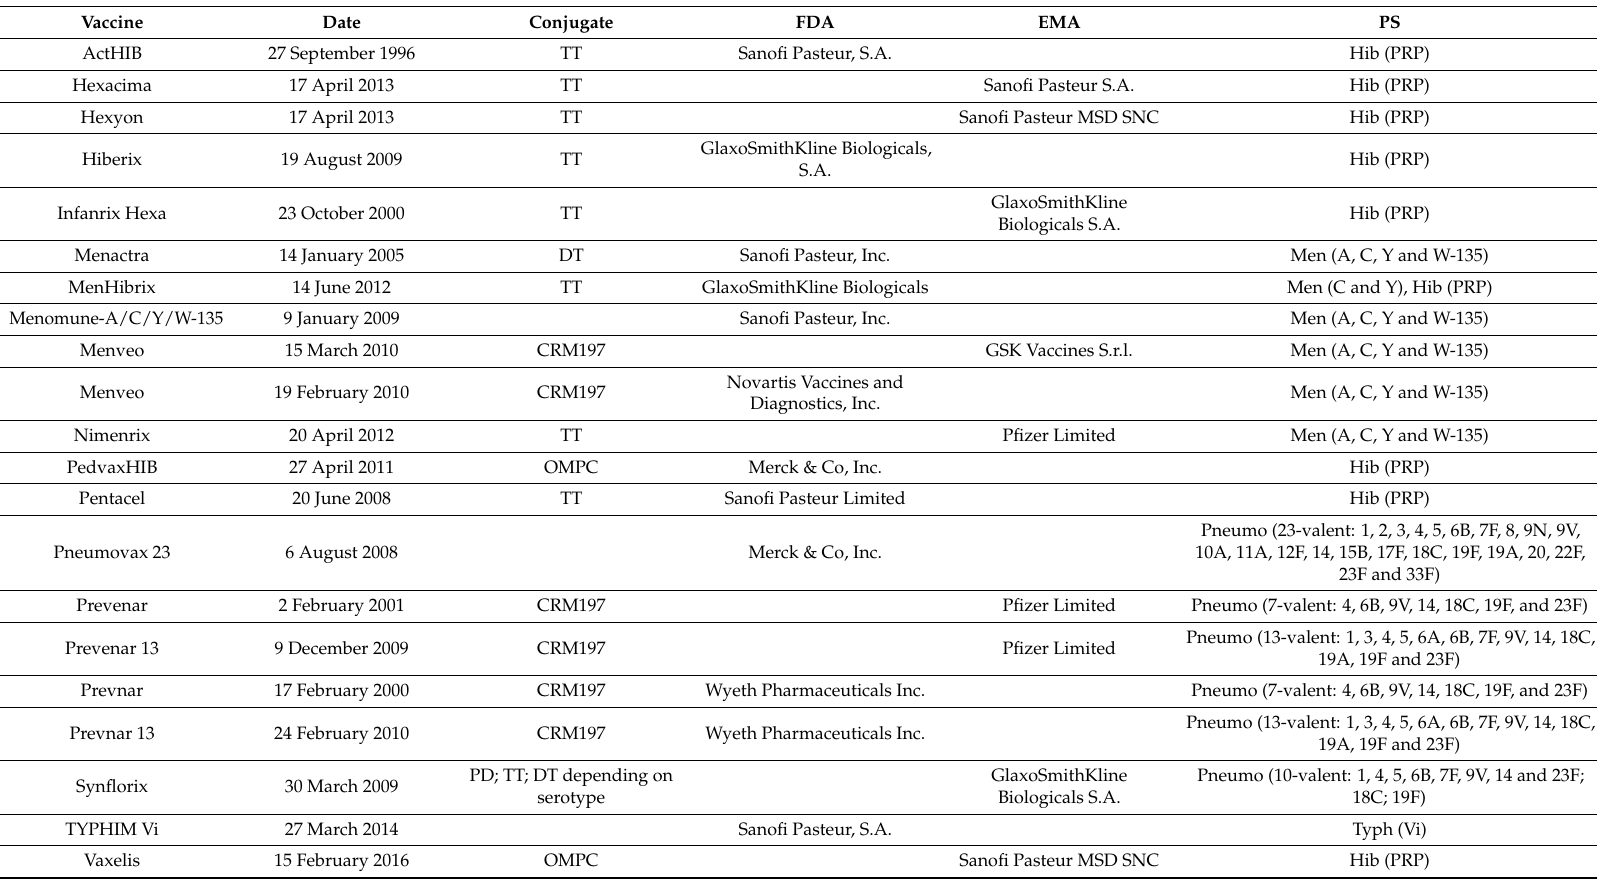
Table 1 lists the Food and Drug Administration (FDA) and European Medicines Agency (EMA) approved PS containing